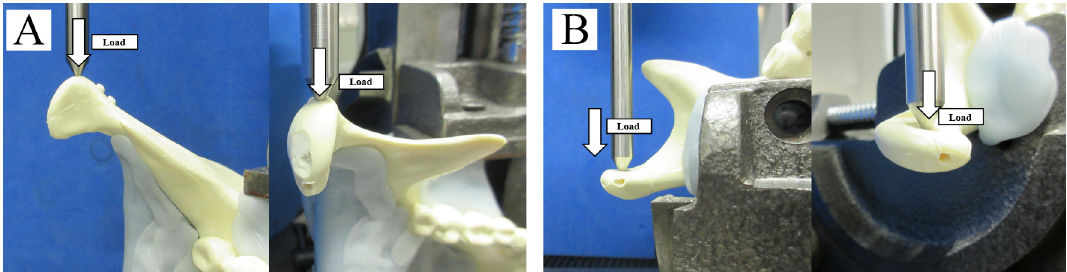
Figure 3. Biomechanical loading test. ( A ) Horizontal (lateromedial) linear loading. ( B ) Vertical (anteroposterior) linear loading.